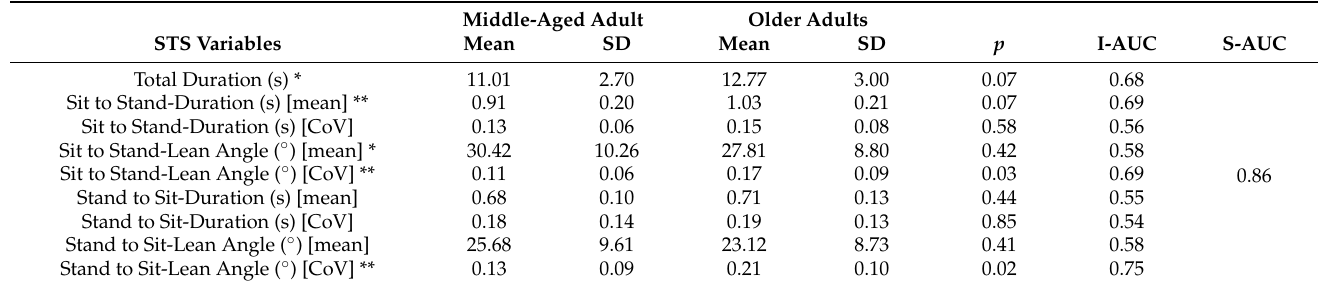
Table 7. Means, standard deviations, significance ( p ), independent AUC (I-AUC), and stepwise AUC (S-AUC) measures for 5 × STS variables. Variable(s) with a single (*) were included in the stepwise regression.